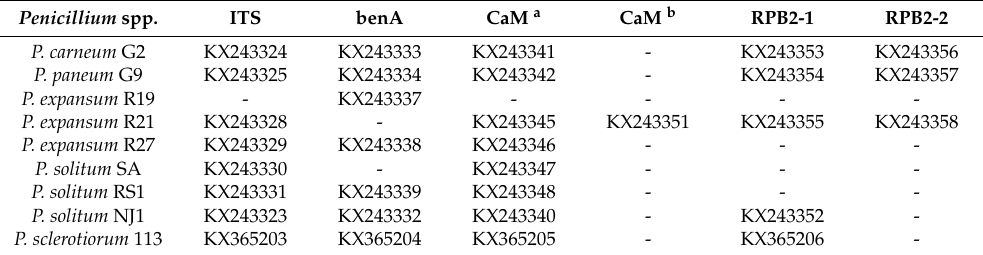
Table 3. Accession numbers of amplified nucleotide sequences from Penicillium spp. isolates. Penicillium